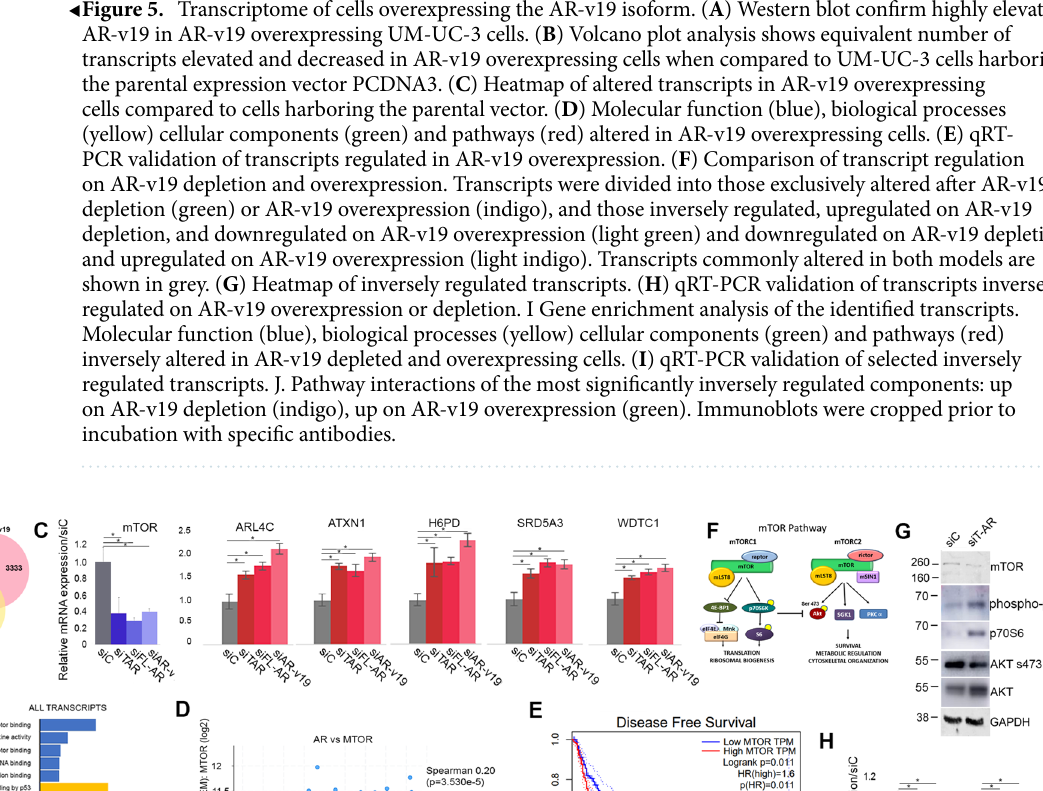
Figure 6. Transcripts commonly regulated on depletion of all or different AR isoforms. ( A ) Venn diagram showing transcripts commonly regulated on depletion of FL-AR, AR-v19 or T-AR (total) isoforms. ( B ) Analysis of commonly regulated molecular function (blue), biological processes (yellow), cellular components (green) and pathways (red). ( C ) Validation of selected transcripts. ( D ) Interrogation of TCGA data identified a statistically significant correlation between AR and mTOR expression in high grade BlCa. ( E ) Kaplan–Meier curves (GEPIA2) identified a significant association between high mTOR levels and decreased disease-free survival. ( F ) Schematic of mTOR complex 1 and 2 signaling pathways. G. Western immunoblot analysis of mTOR and downstream components. ( H ) Pharmacological targeting of both mTOR complexes using INK128 reduces cell viability in a dose and time dependent manner. Immunoblots were cropped prior to incubation with specific